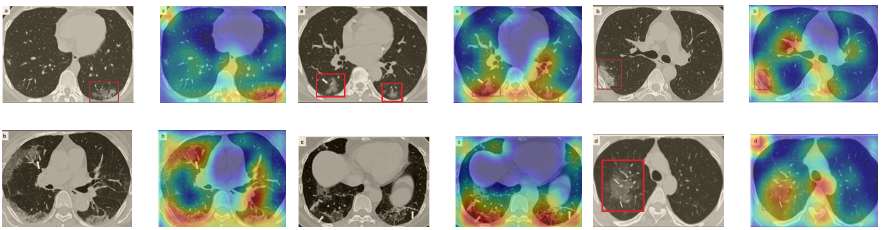
Figure 16. Grad-CAM visualizations for the same CT images in the first two rows of Figure 15. The CT images were correctly identified by SqueezeNet as COVID-19 cases with relevant localization of the disease-related regions.